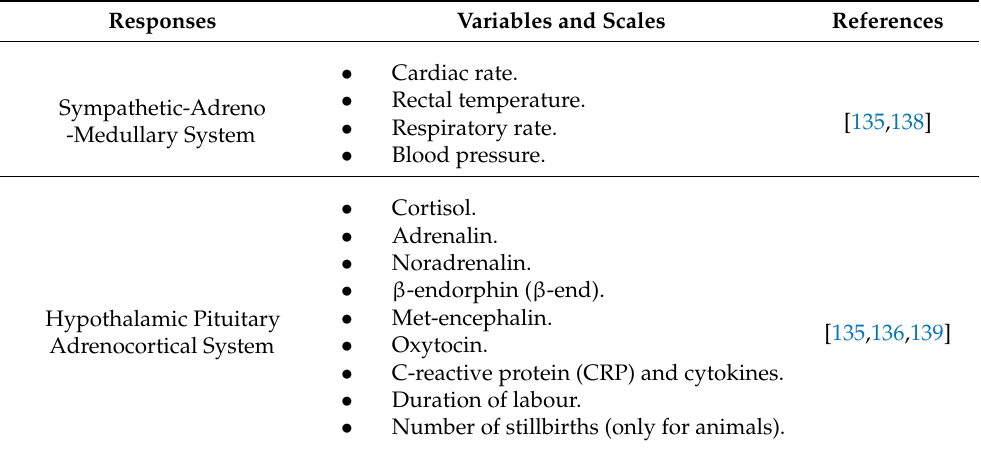
Table 4. Multi-parametric scales for assessing labour pain (physiological indicators) in human Obstetric and Veterinary Medicine.